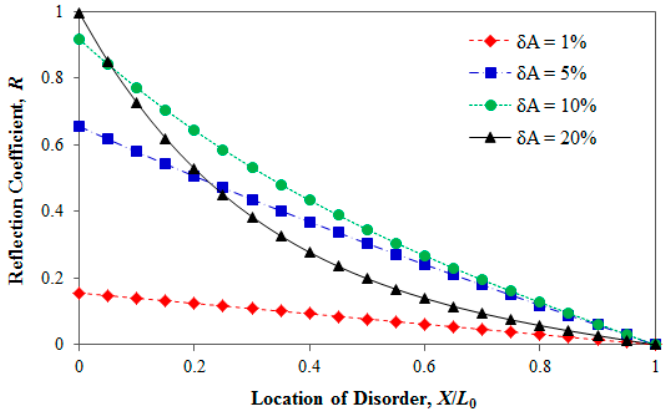
Figure 5. Analytical results of the reflection coefficient for the regular non-uniformities case.